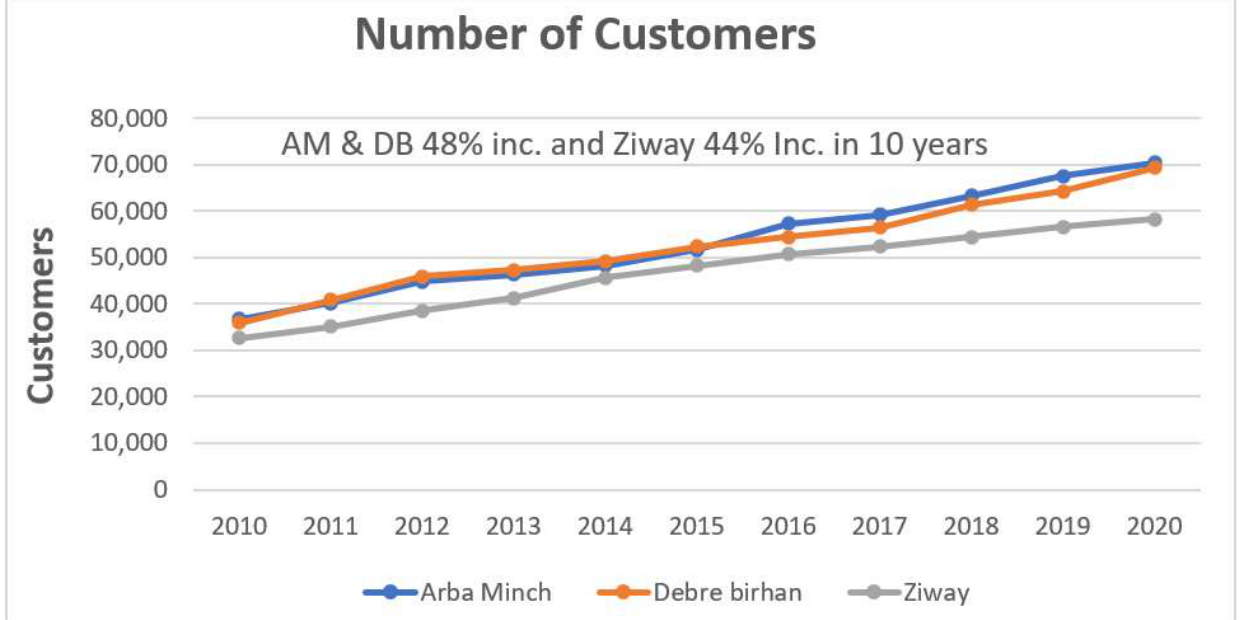
Figure 3. Trends in the number of consumers for the last 10 years .